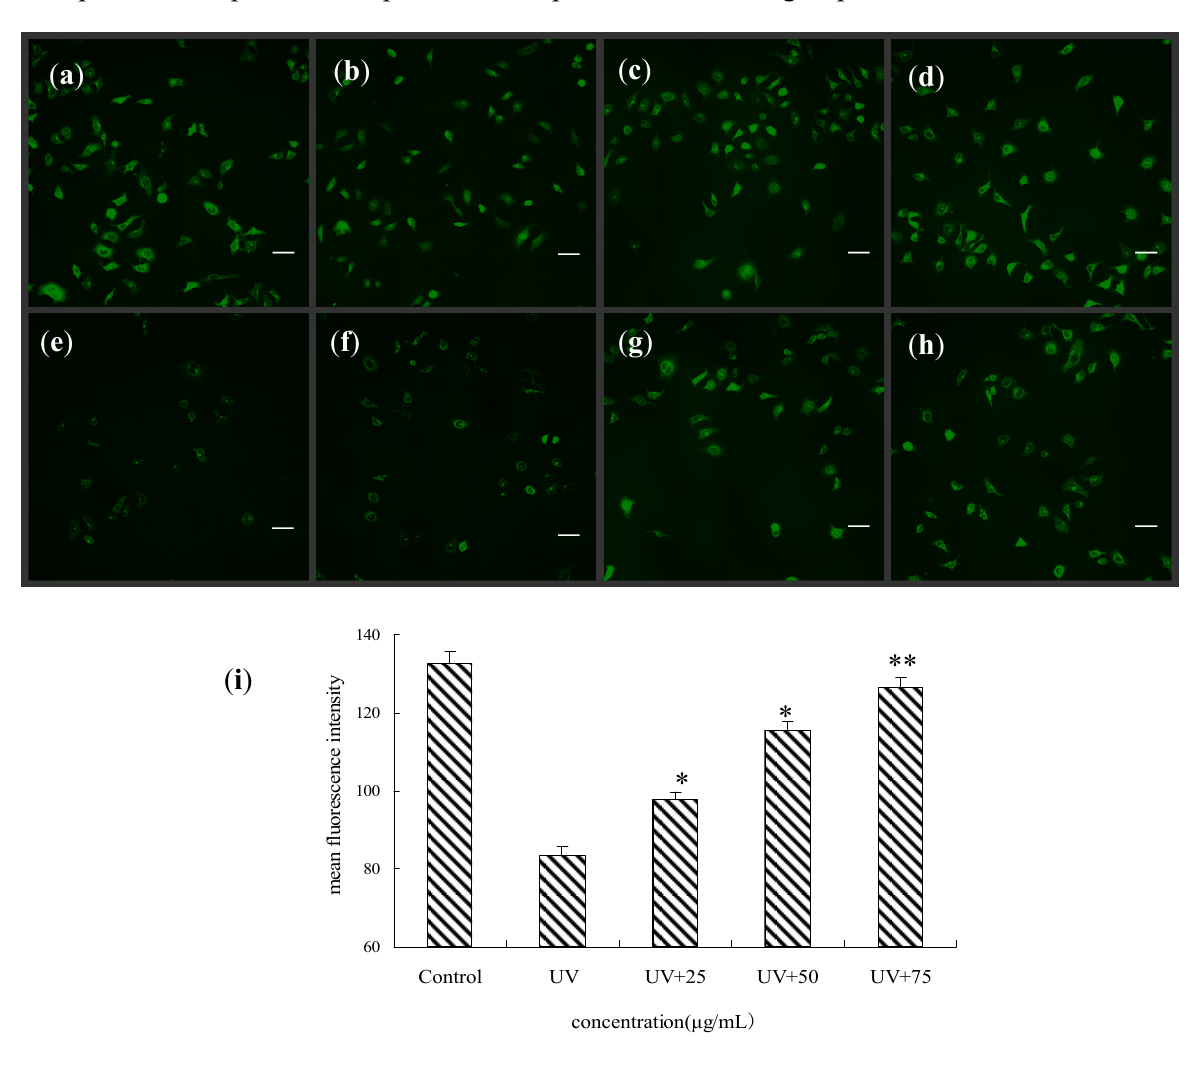
Figure 5. The effects of BA on the membrane potential of mitochondria of UV-irradiated HepG2 cells. Loss of the mitochondrial membrane potential ( ΔΨ m) was observed at 488 nm (scale bar: 50 μ M). ( a ) control (without UV radiation); ( b ) 25 μ g/mL BA; ( c ) 50 μ g/mL BA; ( d ) 75 μ g/mL BA; ( e ) UV-radiation without BA; ( f , g , and h ) were UV + 25 μ g/mL BA, UV+ 50 μ g/mL BA, UV + 75 μ g/mL BA, respectively; ( i ) the mean fluorescence intensity of 20 cells selected at random was determined. Each value represents the mean of three experiments. * p < 0.05, ** p < 0.01, compared with the UV